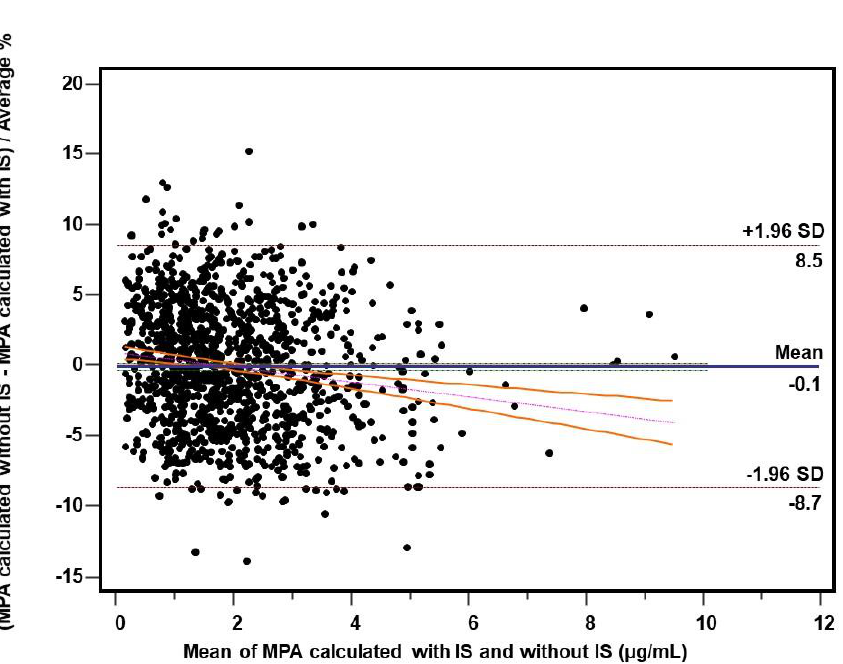
Figure 3. Comparison of calculation methods made on a total of 1187 samples from heart transplant patients. Bland–Altman analysis—plot of difference against mean for MPA concentrations (µg/mL) obtained without using IS and with using IS presented as percent value. Horizontal lines represent bias (solid: mean, dashed: ±1.96 SD), whereas the regression line of differences (with its 95% CI) is indicated by dotted line.